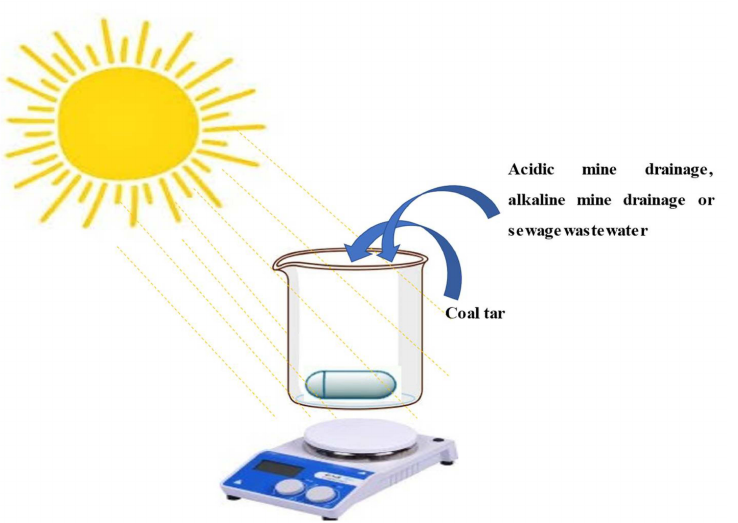
Figure 1. Experimental setup for the photodegradation of PAHs without a flat-bed photoreactor.